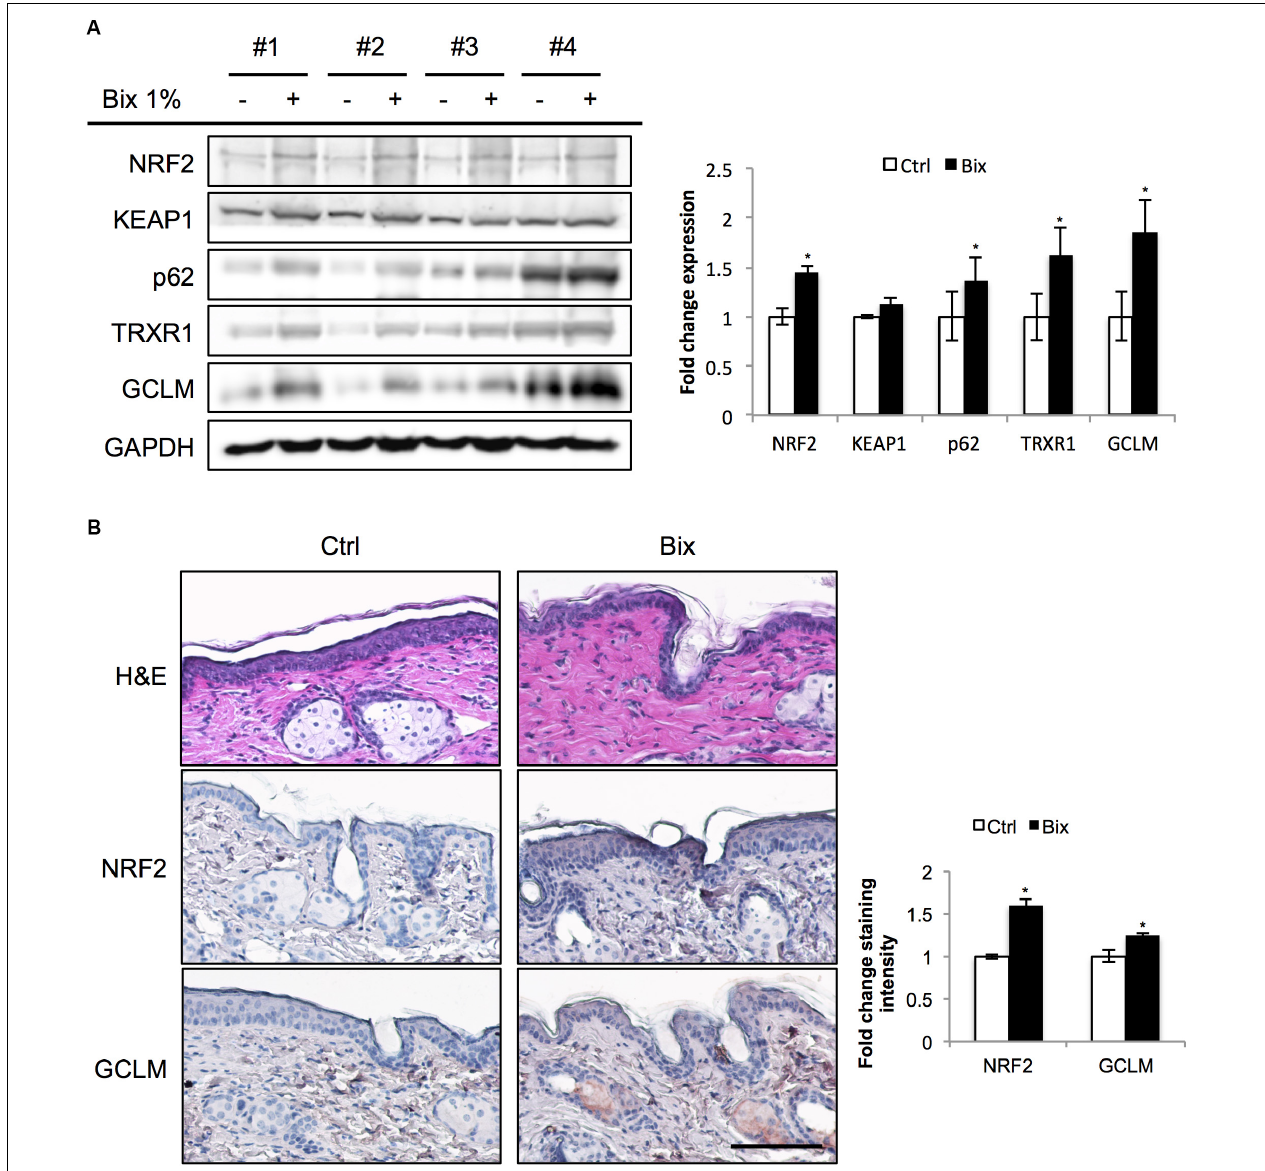
FIGURE 1 | Topical bixin application activates NRF2 in SKH1 mouse skin. SKH1 Nrf2 + / + mice were treated with PEG400 vehicle control ( − ) on half of their dorsal skin and 1% bixin ( + ) on the other half. Skin tissues were collected 1 day later. (A) Protein expression of NRF2 and its downstream genes in skin tissue lysates as assessed by immunoblot analyses in four individual mice. Protein expression was quantified, normalized, and represented as fold change compared to controls. (B) Histological analyses by H&E and immunohistochemical staining for NRF2 and its target gene GCLM. Images representative of specific treatment groups are shown. Scale bar: 10 µ m. ∗ p < 0.05 compared to